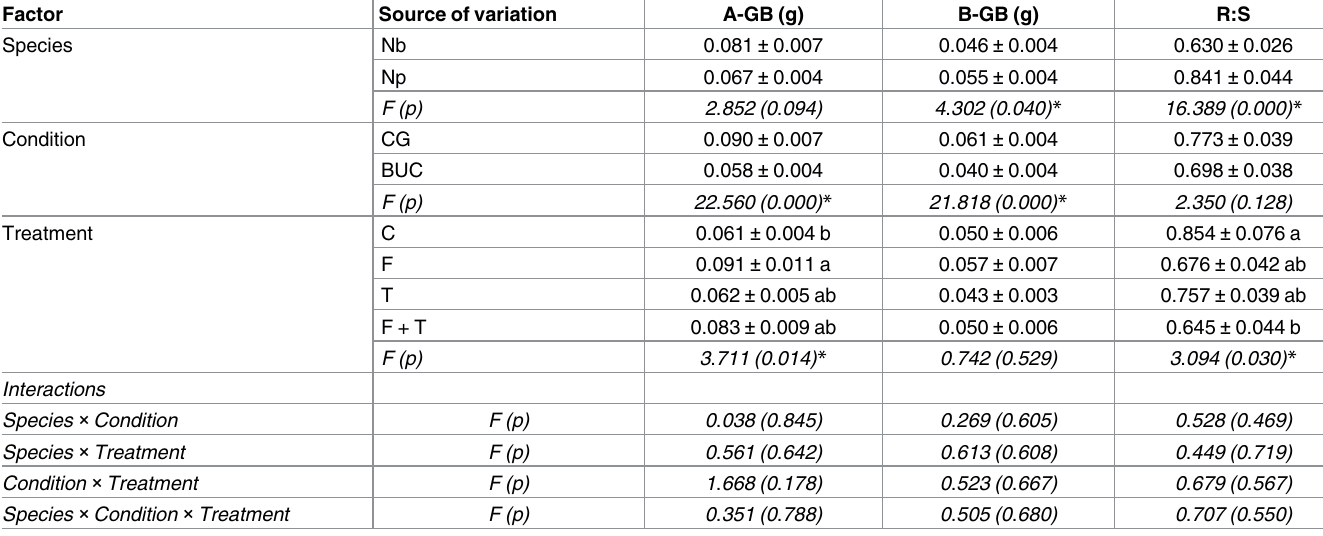
initial seedling RCD or height between canopy gaps and undisturbed canopy, particularly for the less shade tolerant N . pumilio [15–16]. The absence of an initial size difference may partly reflect a short-term nutritional lag affecting growth. The canopy gaps studied were recent and nutrients likely remain sequestered in the relatively undecomposed fallen tree trunks that Table 5. Three-way ANOVA for mean ( ± SE) above-ground biomass (A-GB), below-ground biomass (B-GB) and root to shoot biomass ratio (R:S) of seedlings per plot by species, canopy condition and treatment as main